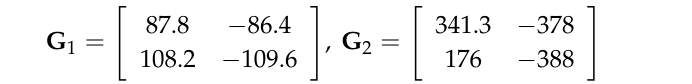
(cid:112) var ( ξ 2 ) /var ( ξ 1 ) .